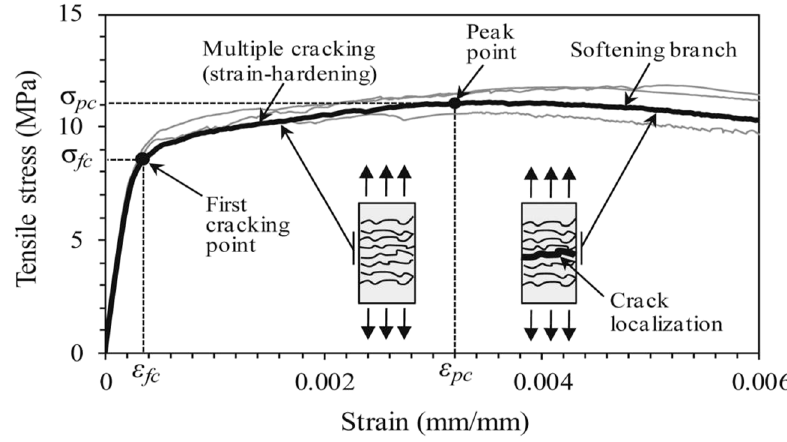
Figure 1: Tensile stress and stress characteristics of UHPFRC [ 14 ]